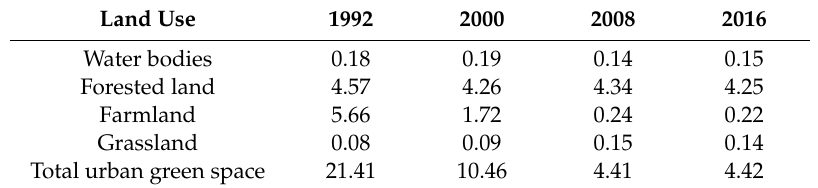
Table 3. Largest patch index values of green space in central Beijing for the period